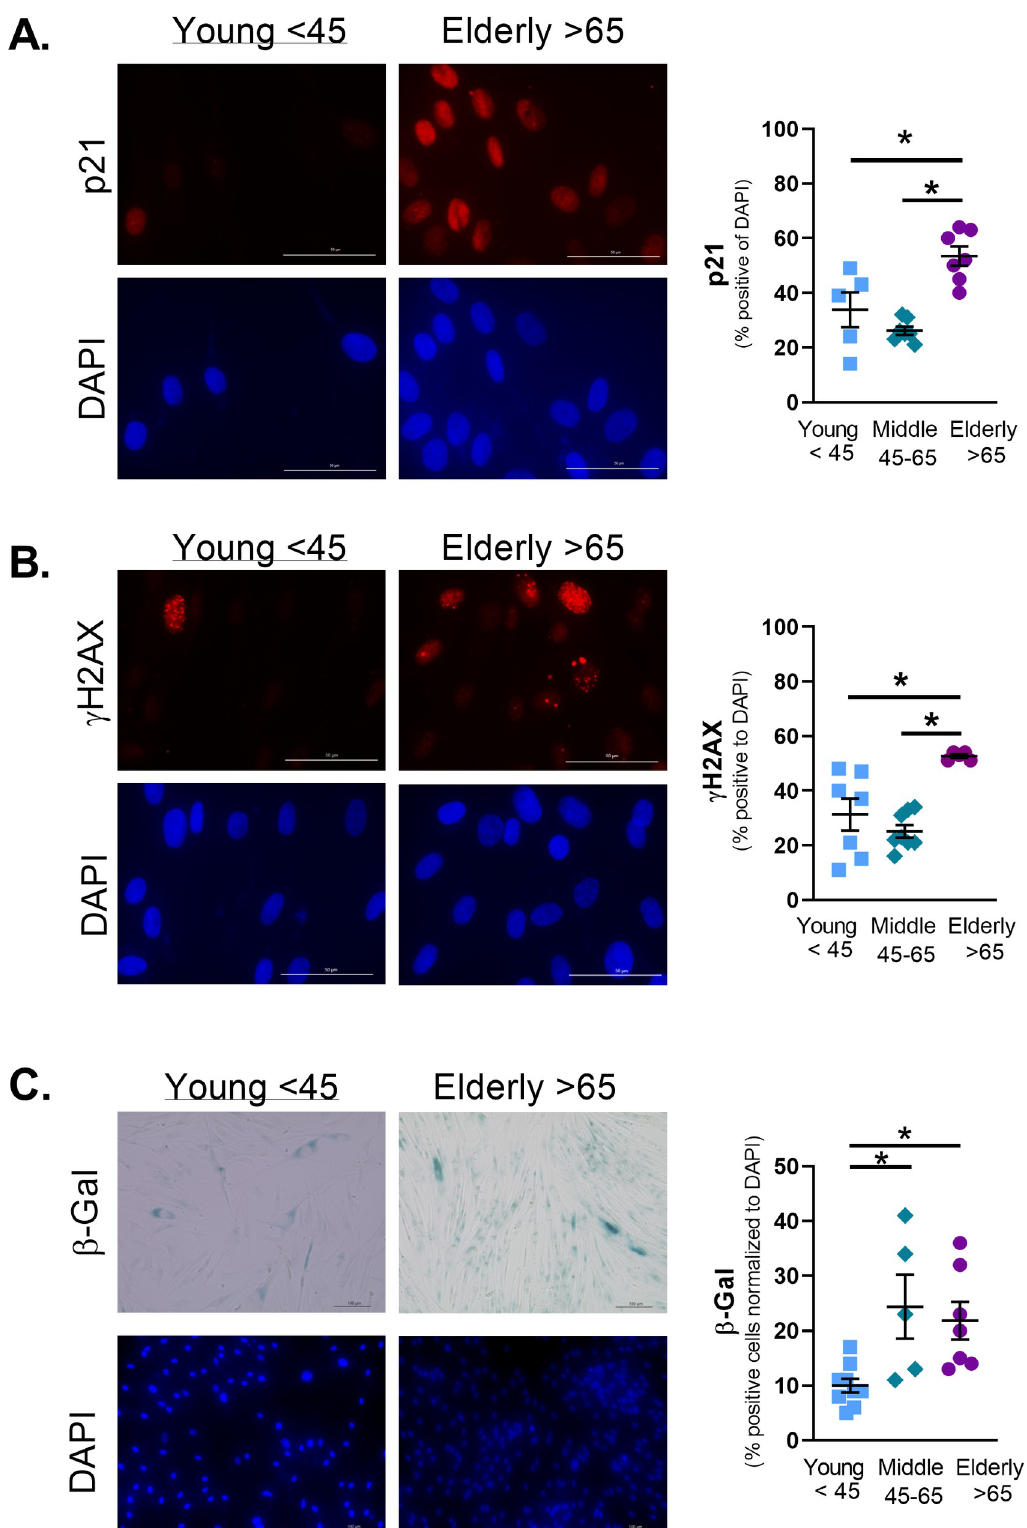
Fig 2. Aging increases senescence markers in ASM. Immunofluorescence staining for p21 a marker of cell cycle arrest (A) showed increased levels in elderly ASM. γ H2AX, a marker for DNA damage, increased in elderly ASM (B). Staining